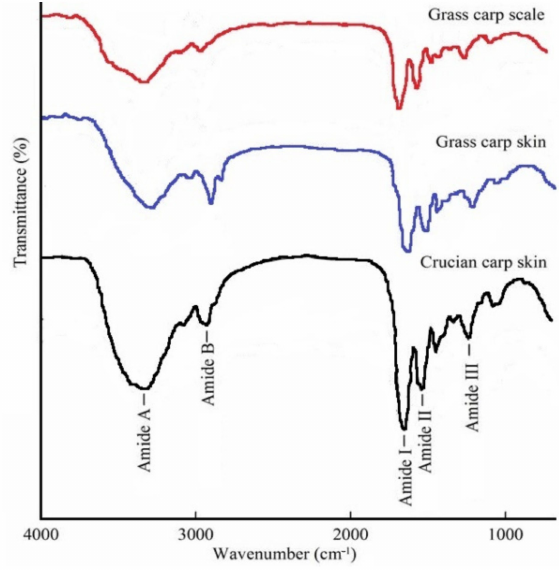
Figure 2. Fourier-transform infrared spectra of type I collagens from grass carp skin, grass crap scales, and crucian carp